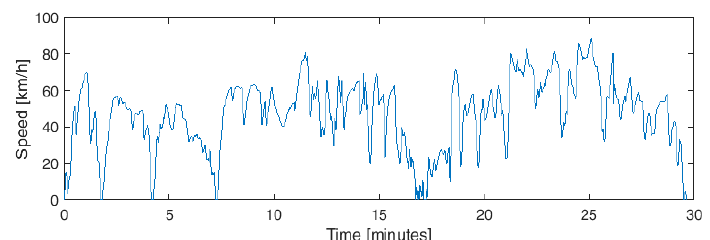
Figure 11. Mountain mission 1 speed profile.